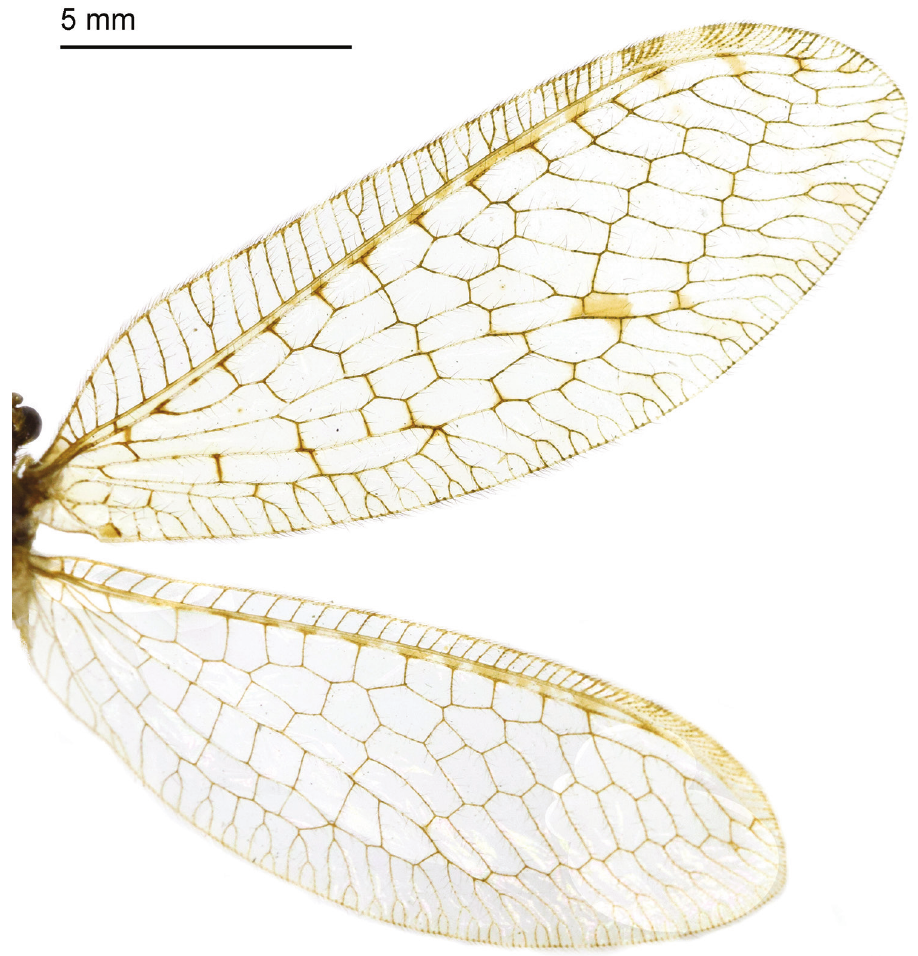
Figure 29. Wings of Heterosmylus flavidus Yang, 1992. from Chinese)]: CHINA: Yunnan Prov., Lushui, Yaojiaping/ 04.vi.1981/ Shuyong Wang/ CAU. Paratype Male, CHINA: Yunnan (Province): Lushui, Pianma, 29.v.1981. leg. Xuezhong Zhang. [Verbatim label data (translated from Chinese)]: CHINA: Yun- nan Prov., Lushui, Pianma/ 29.v.1981/ Xuezhong Zhang/ CAU. Diagnosis. Pronotum with a dark brown longitudinal stripe medially; metanotum with a brown spot in middle; forewing light yellow; mediuncus C-shaped in lateral view and scoop-shaped in dorsal view. Redescription. Body length 7–9 mm. Head . Vertex dark brown, frons yellow; ocelli yellowish; Compound eyes brown with some small spots; antennae fuscous ex- cept for the yellow scape; clypeus yellow, maxillary and labial palpi black. Thorax . Mostly yellow. Pronotum with a brown longitudinal stripe, and with some long